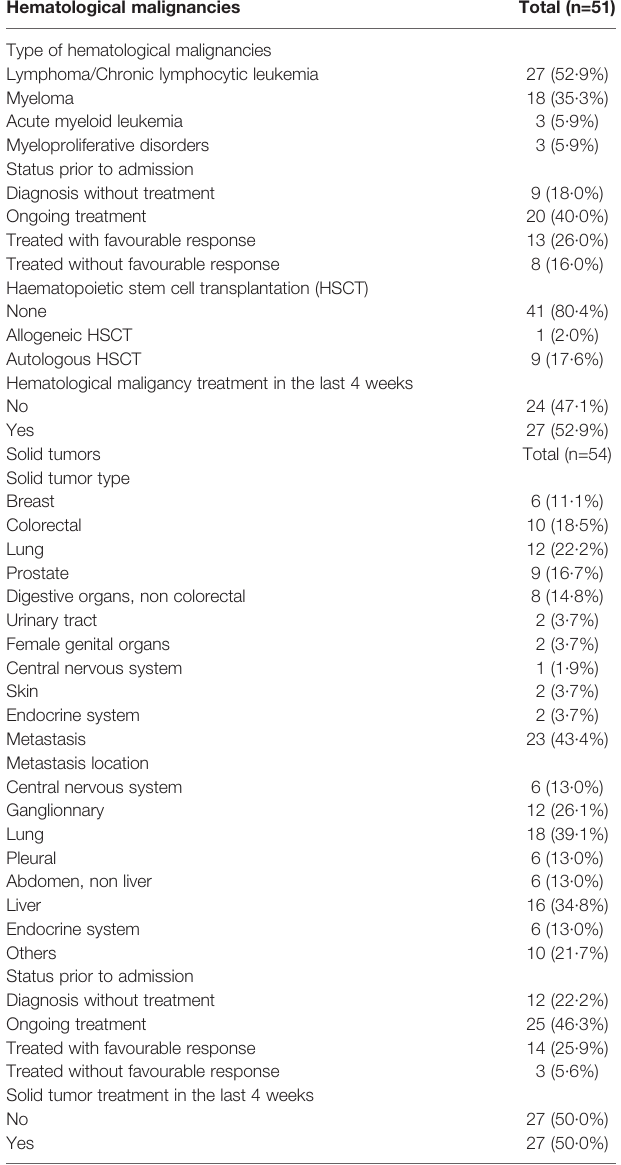
TABLE 2 | Characteristics of hematological malignancies and solid cancer. Hematological